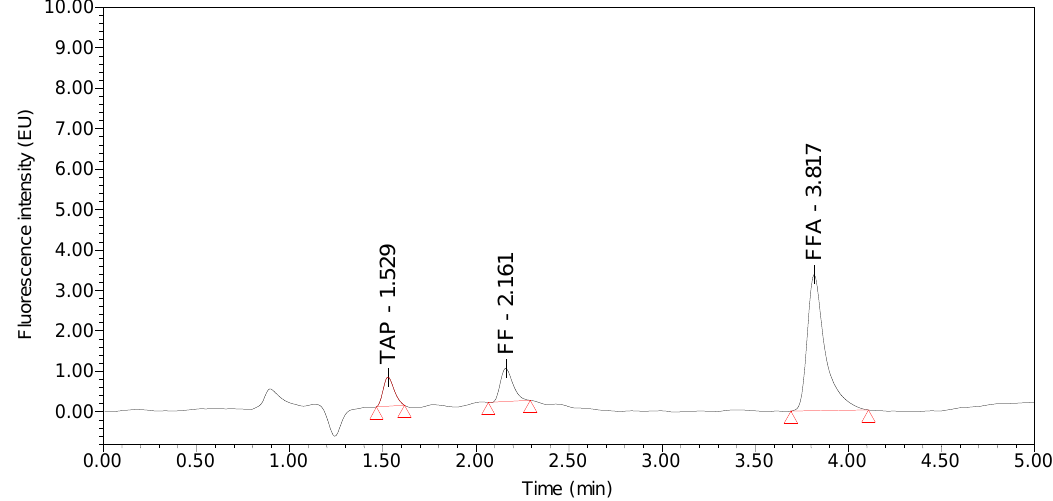
Figure 4. Chromatogram of the standards (25 µg/kg TAP and 50 µg/kg FF and FFA standards).